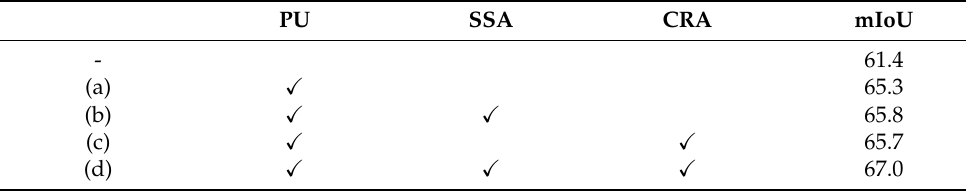
Table 1. Comparison of different settings in Class-Prototype